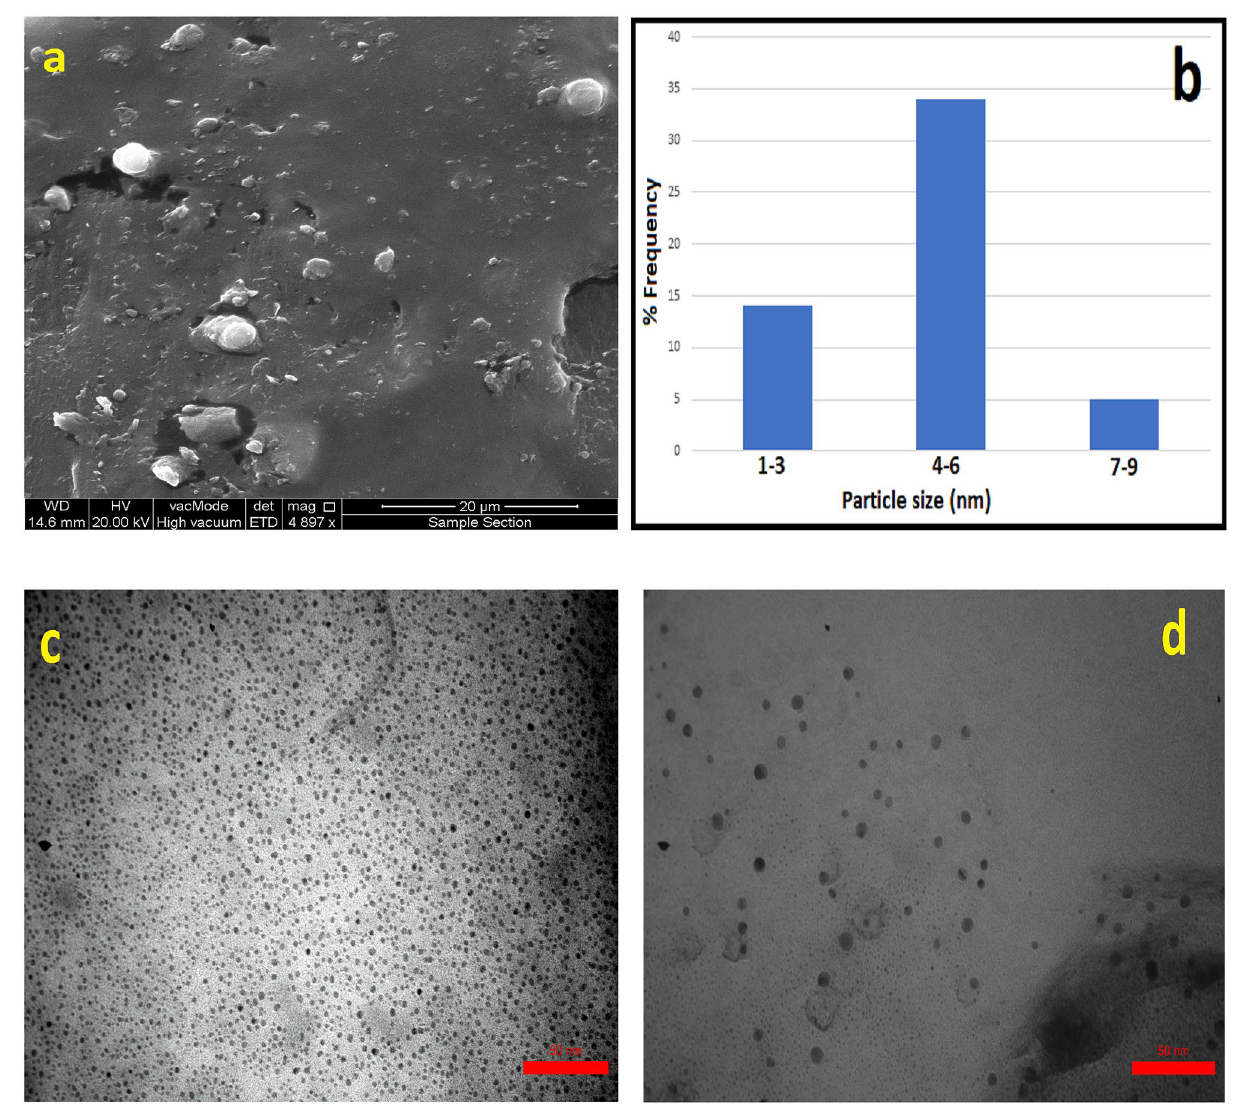
Figure 3. (a) FE-SEM analysis , (c and d) TEM analysis, and (b) Particle size distribution of biosynthesized Ag